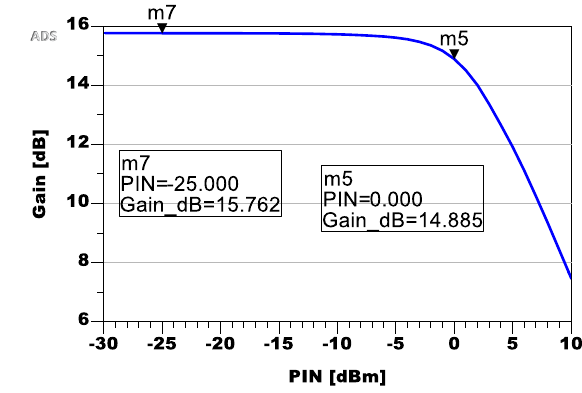
Fig. 19. Large signal gain @ 2.4 GHz